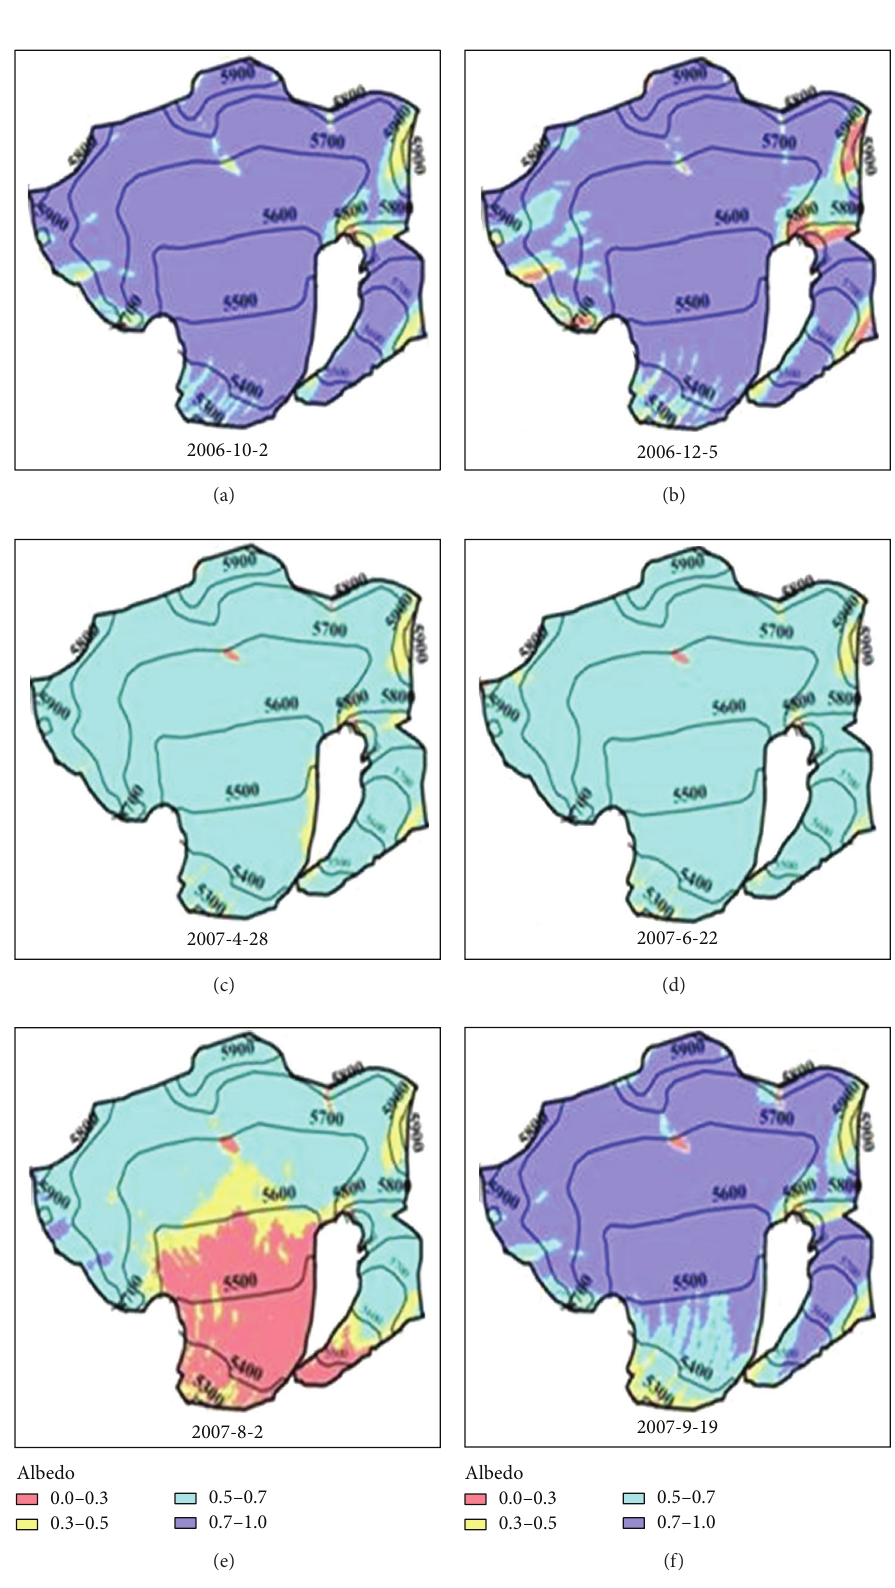
Figure 3: The spatial distribution of albedo on the Dongkemadi glacier in one mass balance year from October 2006 to September 2007. Where the solid lines represent the contour lines, and the numbers represent the altitude values of the contour lines (units: meters